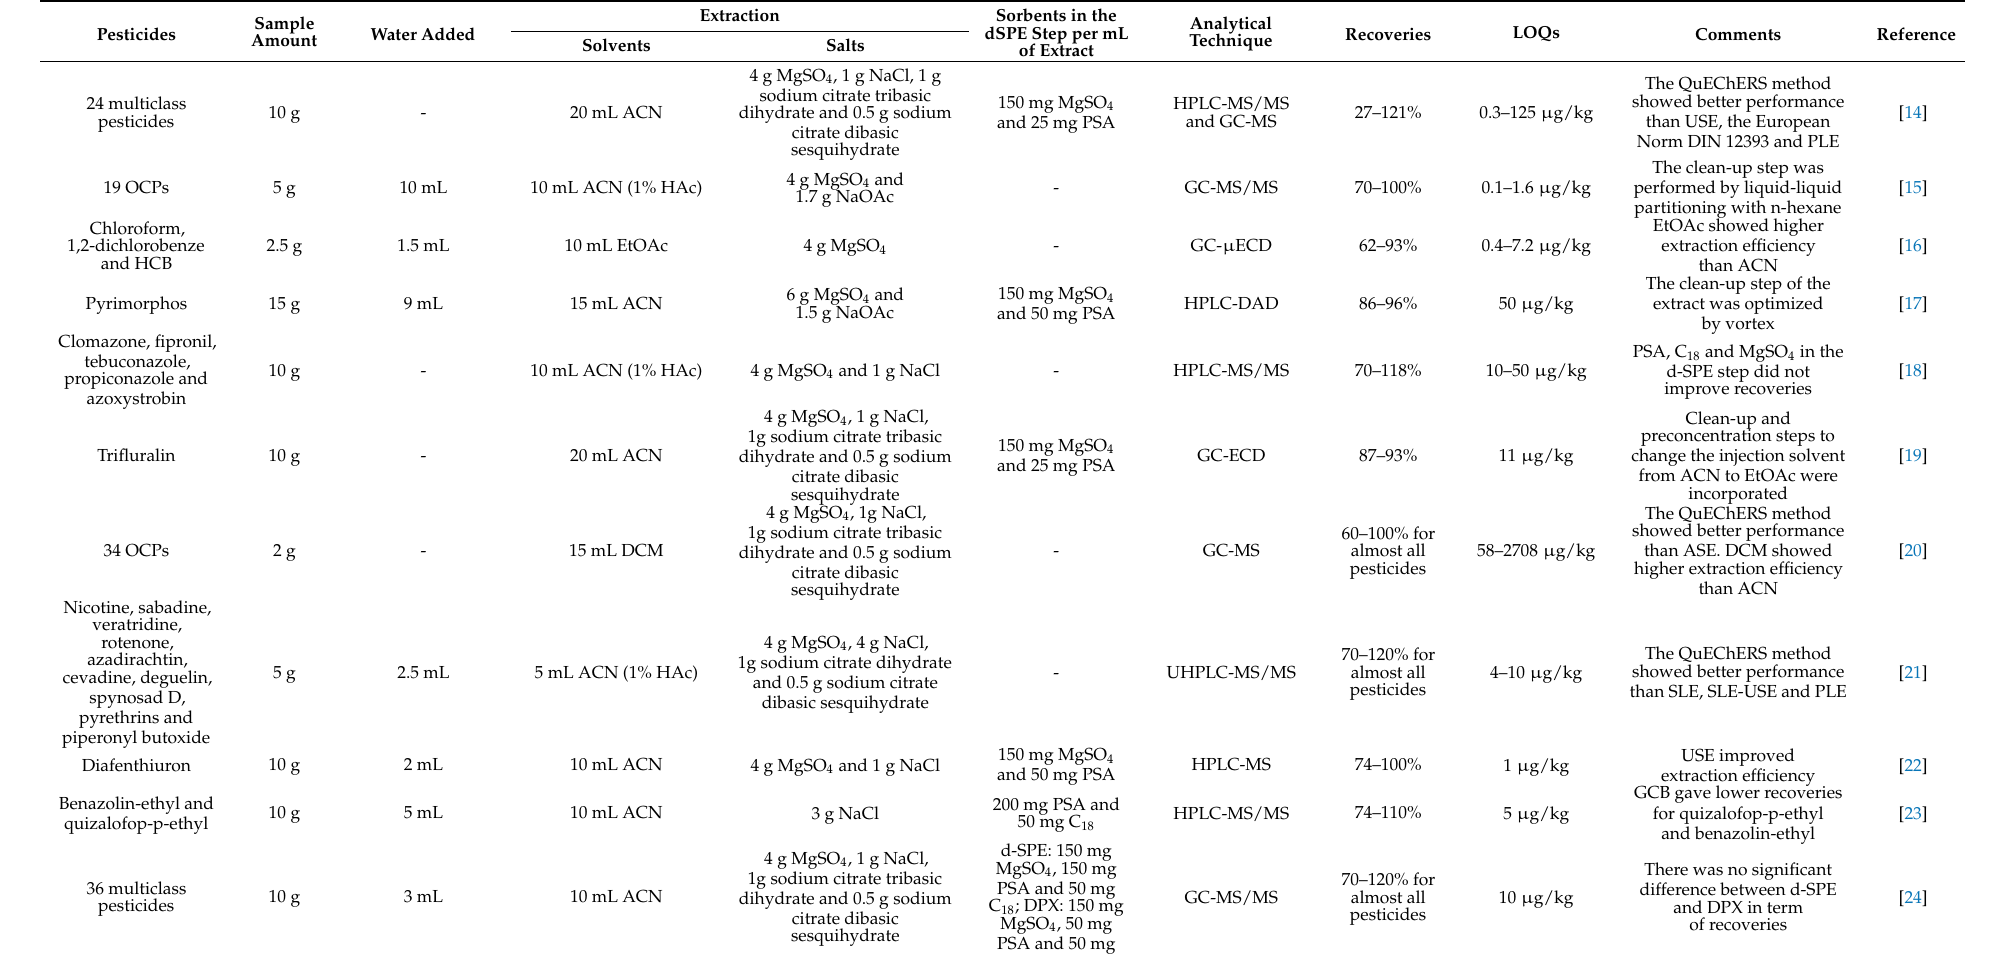
Table 1. Evolution of the QuEChERS method for the analysis of pesticide residues in